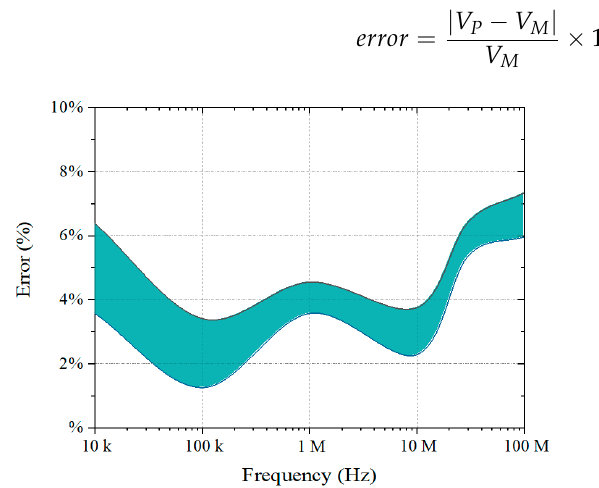
Figure 11. Error analysis of the numerical model.